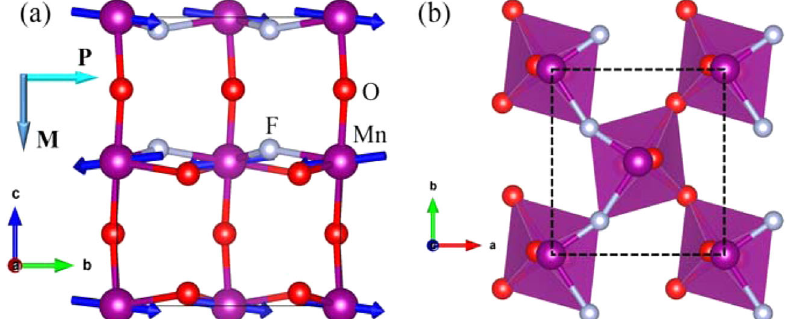
Fig. 4 Design multiferroics based on perovskite structure. Multi- ferroic SrMnO 2 F obtained by replacing one third of O ions by F ions in Pbnm LaMnO 3 (La ions are also replace by Sr ions to maintain the number of valence electrons). a The geometry and magnetic structure of SrMnO 2 F. The Mn 3+ magnetic moments are denoted by blue arrows . Note that the canting of the magnetic moments